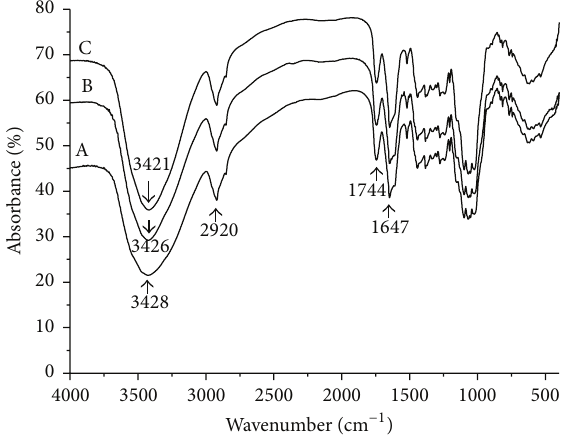
Figure 2: FTIR spectra of the different IDF fractions: (A) regular milled IDF fraction, (B) ultra centrifugal milled IDF fraction, and (C) ball milled IDF